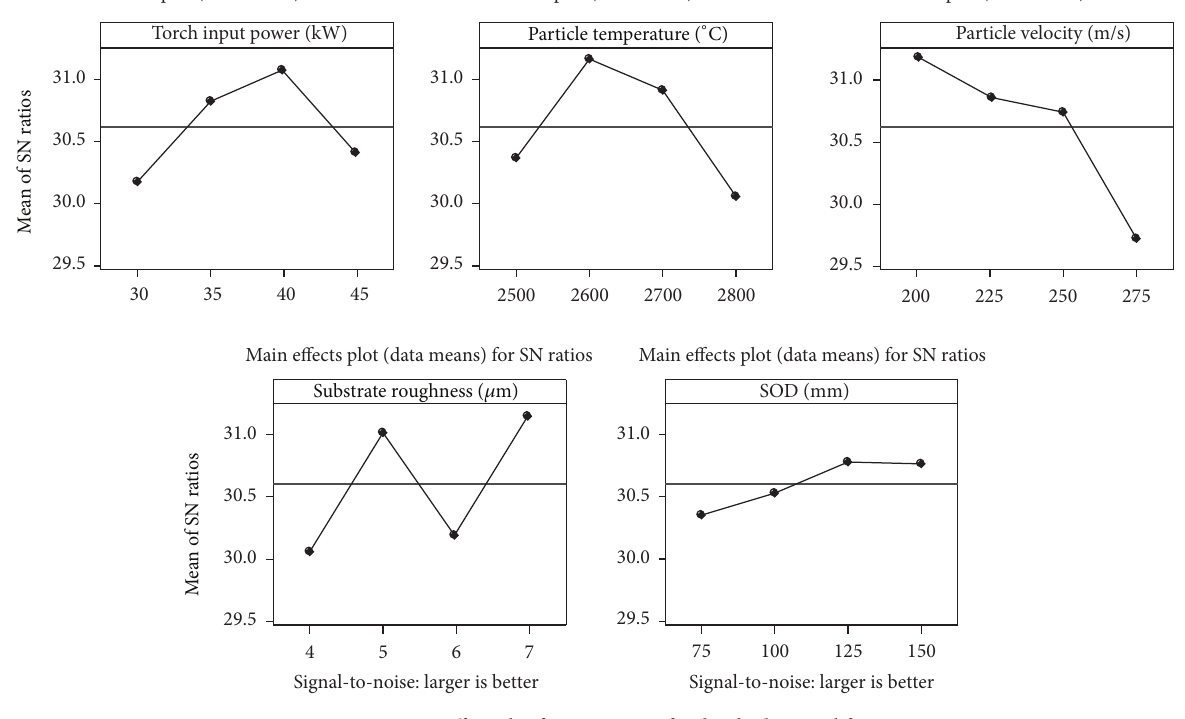
Main effects plot (data means) for SN ratios